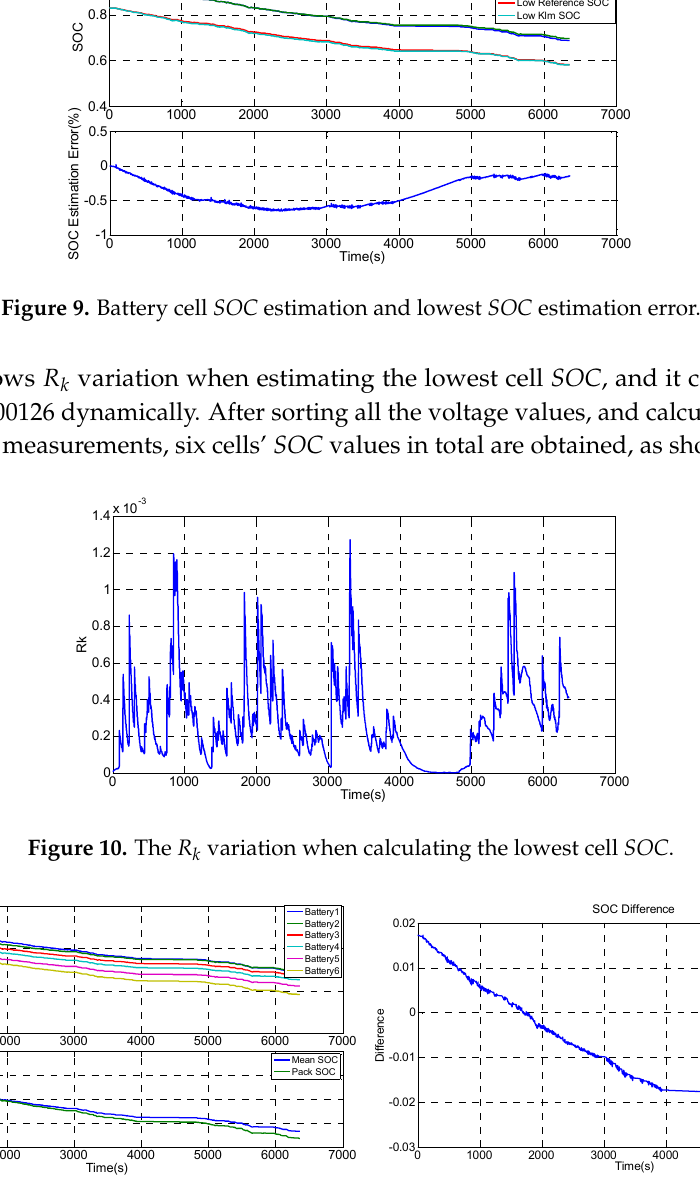
Figure 11. The SOC output comparison based on different methods: ( a ) The cell SOC estimation and the pack SOC estimation based on different methods; and ( b ) the pack SOC difference.